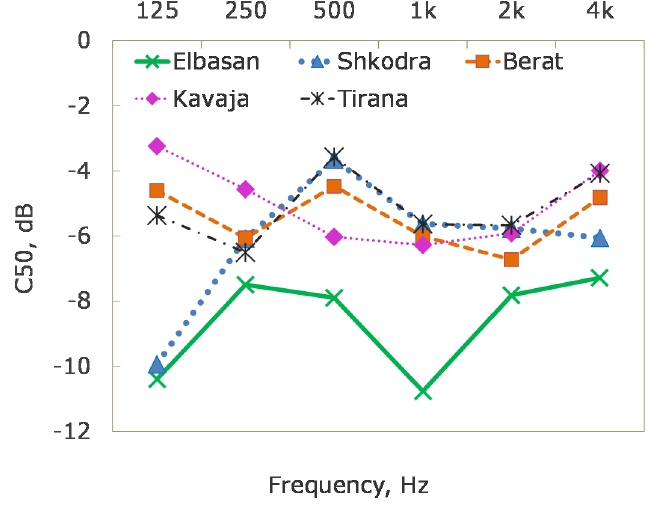
Figure 18. Measured results of clarity index (C 50 ).